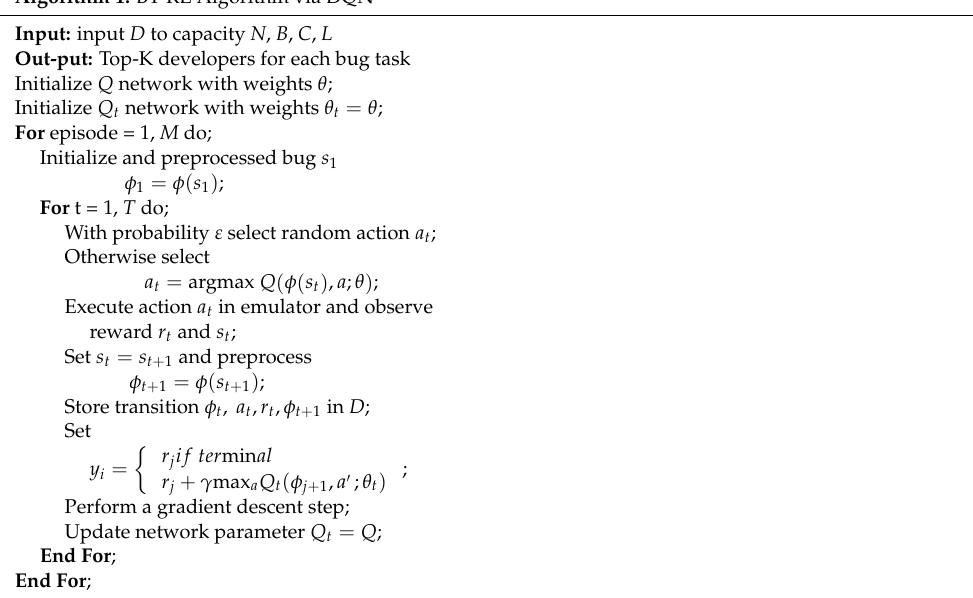
Algorithm 1: BT-RL Algorithm via